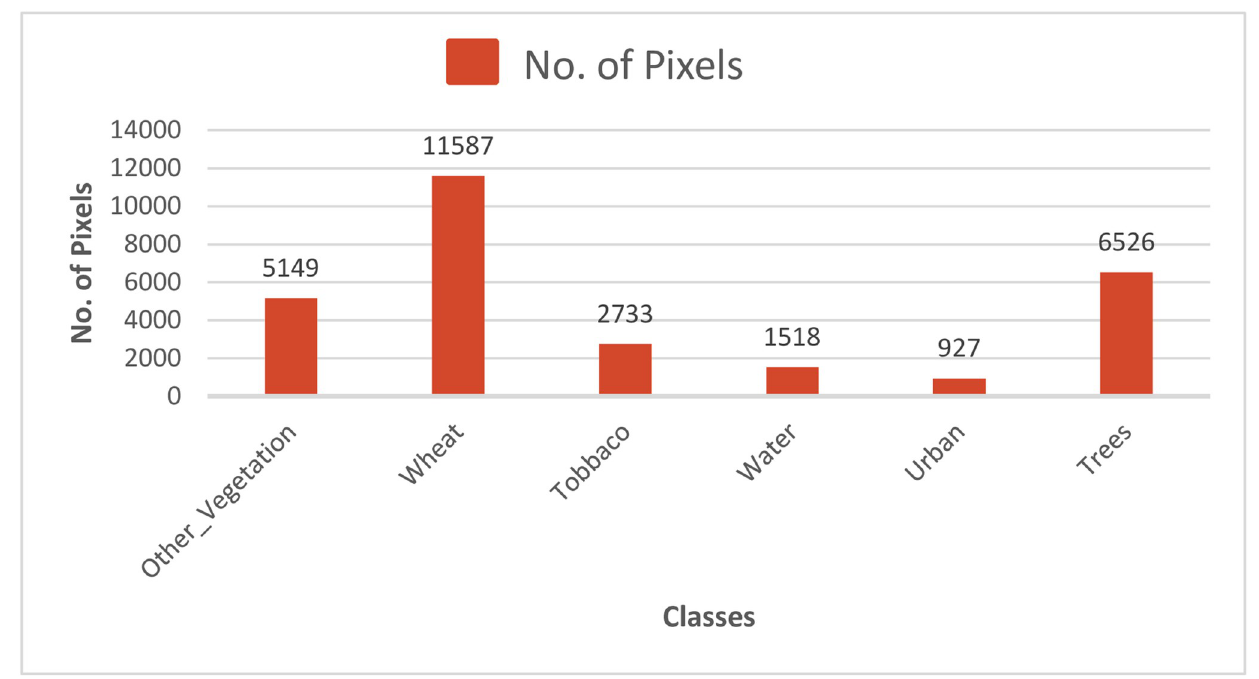
Fig 5. Number of pixels collected for each